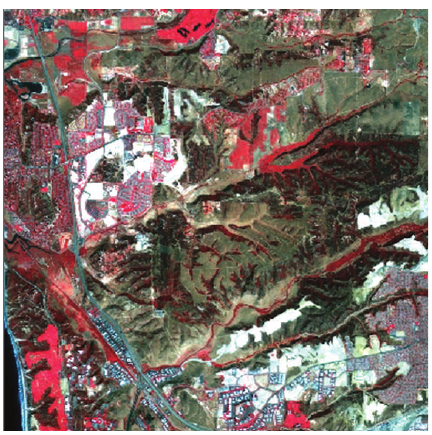
Figure 3: Fusion image based on fussy integral.